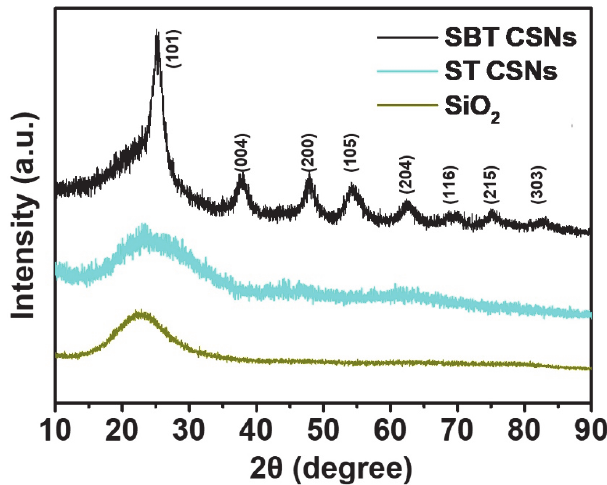
Figure 7. XRD diffraction patterns of 100 nm SiO 2 nanoparticles, 130 nm ST CSNs, and 140 nm SBT CSNs.